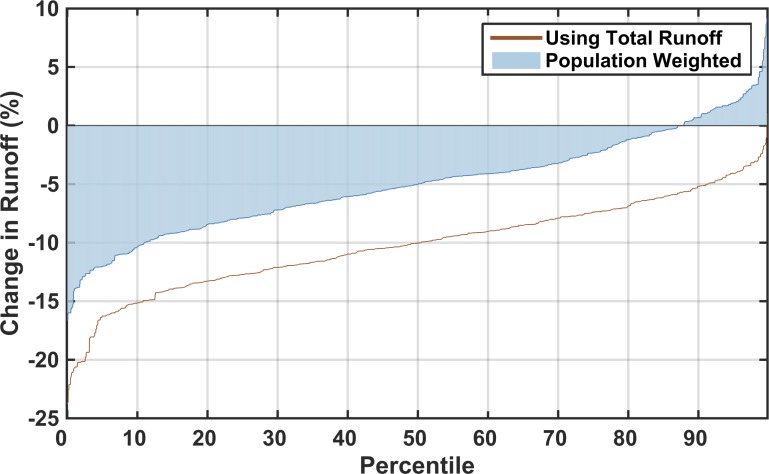
Percentage change in runoff across all ensemble members.Each point in the line represents one of the 551 members with appropriate weights from the Gaussian Quadrature (Section 2.3). The percent change in runoff represents a weighted-averaged result for the entire domain of study region (Fig 1)—such that for every member's result in the distribution shown, each ASR's runoff has been weighted by its population (Fig 3).